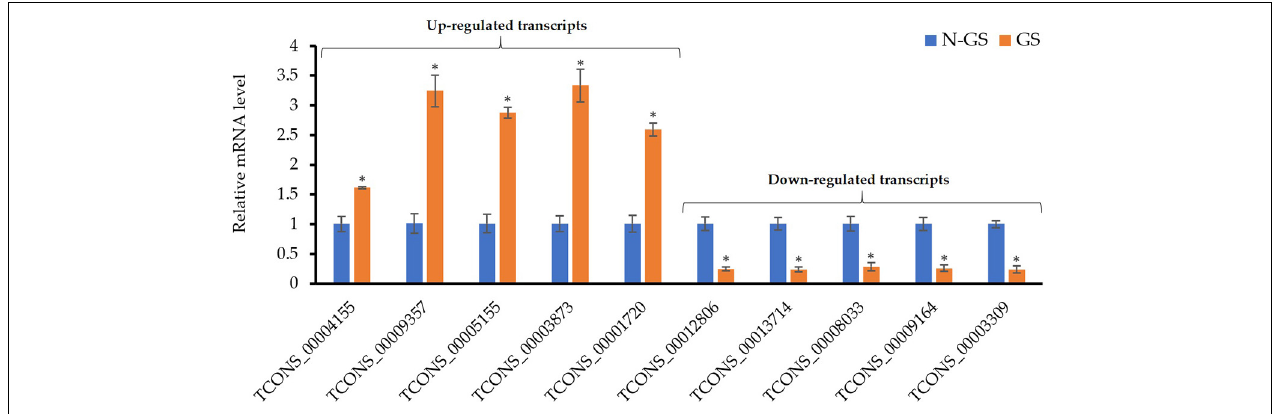
FIGURE 6 | Validation of RNA-Seq results using qRT-PCR. Values are the means of three biological replicates ± SD. Asterisk (*) denotes a significant mRNA difference between germinating (GS) and non-germinating spore (N-GS) for each gene ( P -value < 0.01).